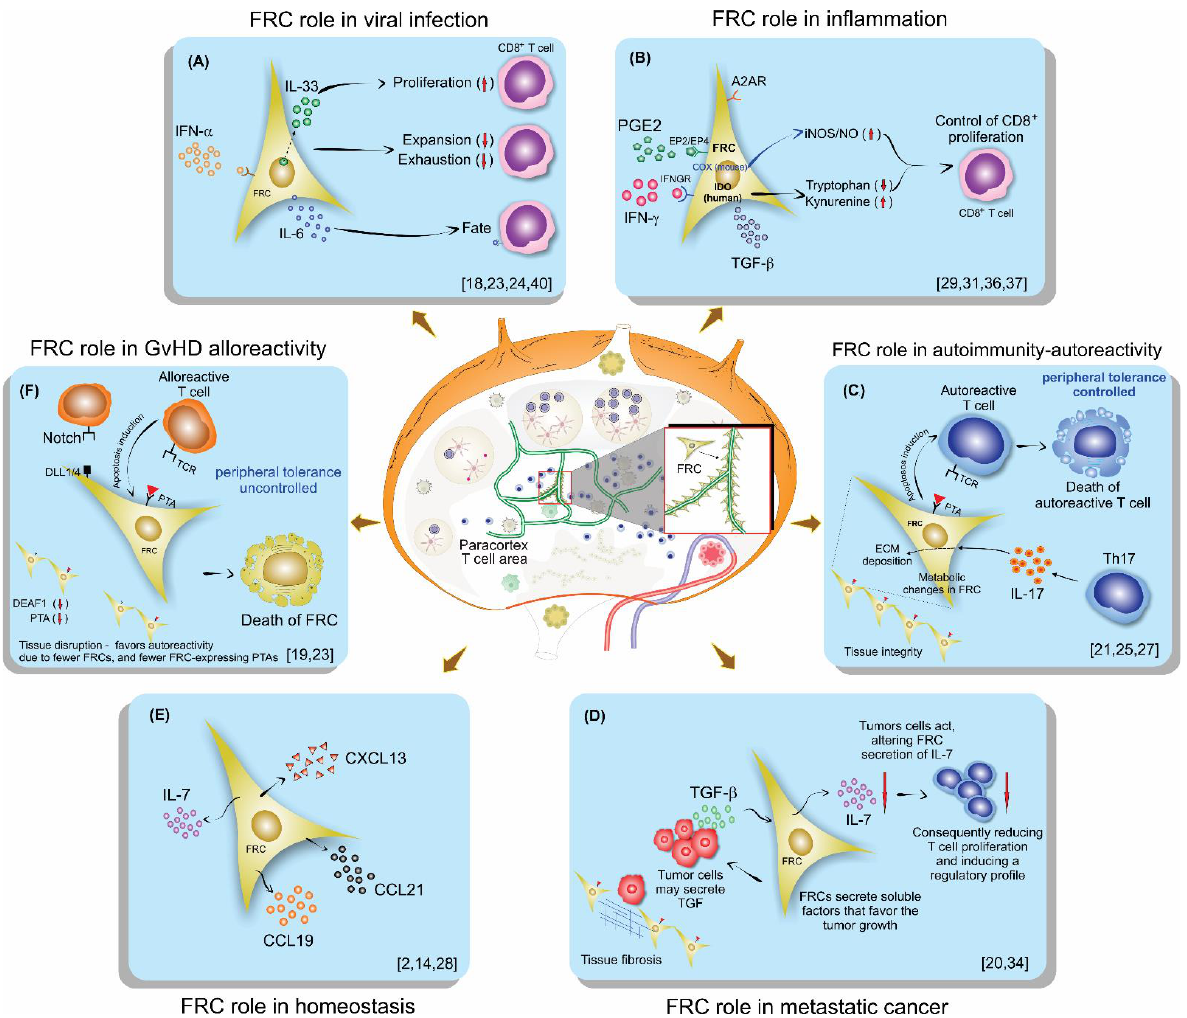
Figure 2. Schematic illustration of lymph nodes, FRC localization, and their role on lymphocytes in different sce- narios of the immune response: ( A ) Viral infection, ( B ) Inflammation, ( C ) Autoimmunity, ( D ) Metastatic cancer, ( E ) Homeostasis, ( F )